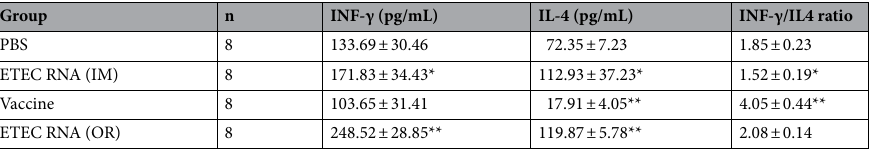
Table 1. Expression of IFN-γ and IL-4 in serum from the administrated mice. Values are means ± SD for eight mice in one group. * P < 0.05 in comparison with the PBS group. ** P < 0.01 in comparison with the PBS group.